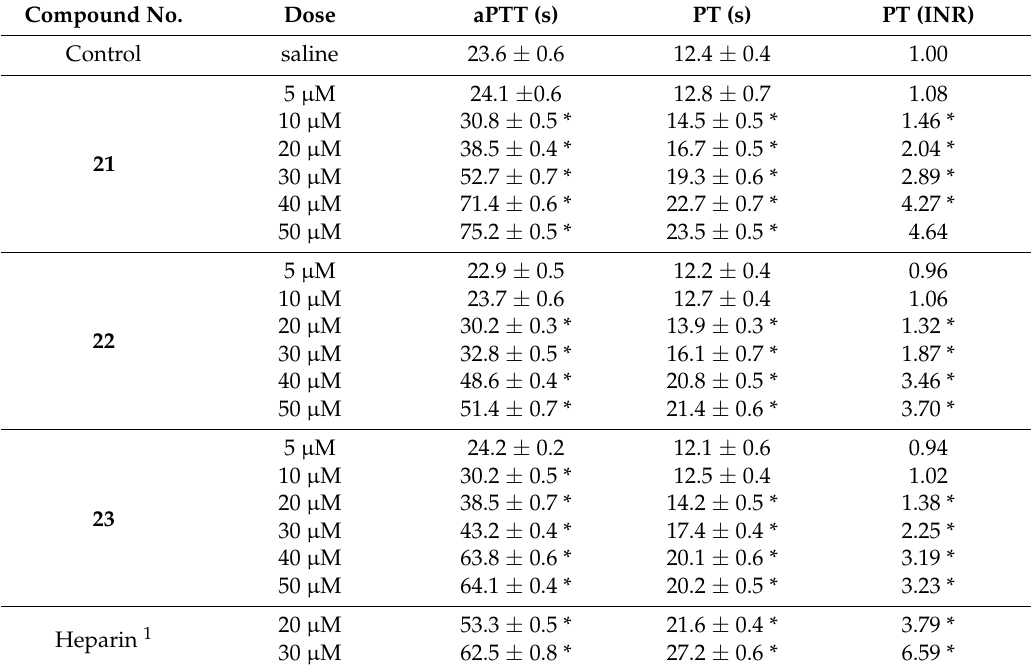
Table 6. In vitro anticoagulant activity of amidino N 2 -thiophene compounds 21 – 23 . Compound